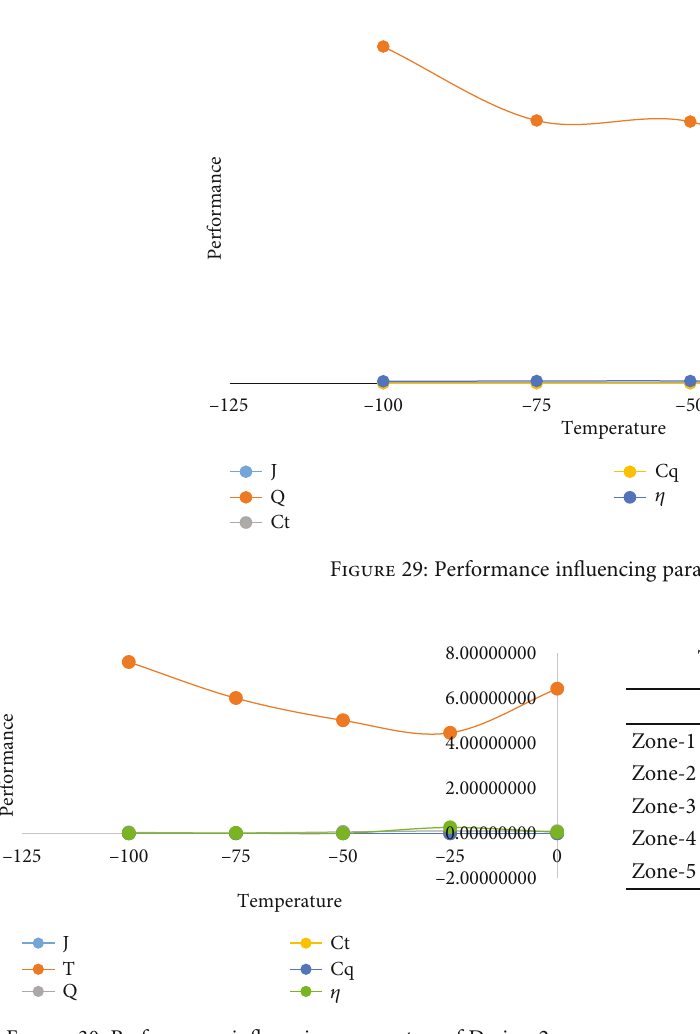
Figure 30: Performance in fl uencing parameters of Design-2.